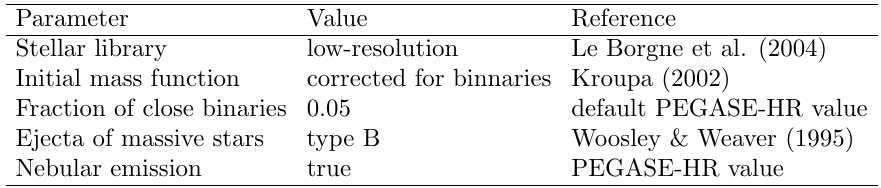
Table 1. PEGASE-HR parameters used to generate